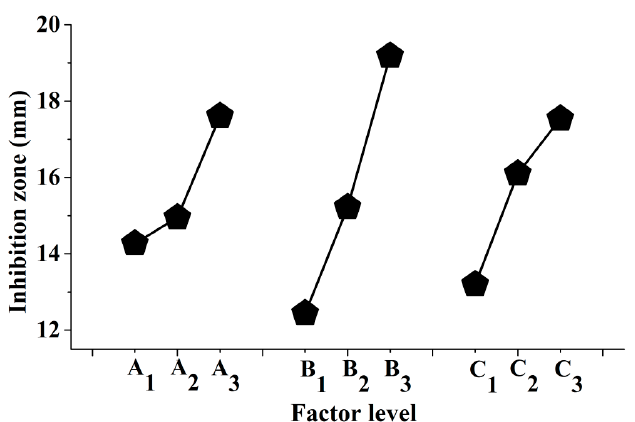
Fig. 1: Effect of parameters on extraction: A, extracting time: A 1 : 4 h, A 2 : 8 h, A 3 : 12 h; B, extracting temperature: B 1 : 40 °C, B 2 : 60 °C, B 3 : 80 °C; C, solid/liquid ratio (g:mL): C 1 : 1:10, C 2 : 1:20, C 3 : 1:30.